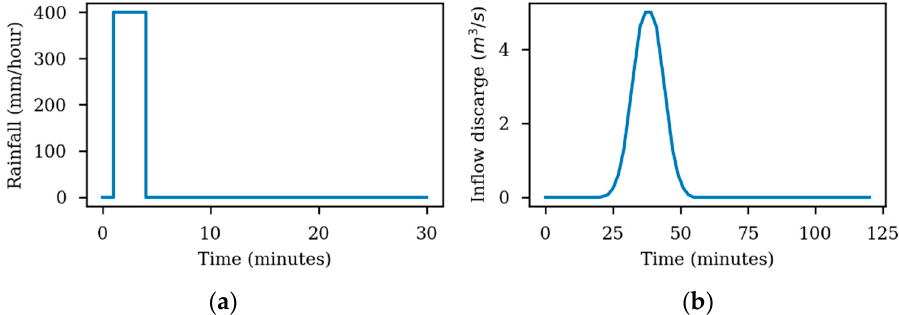
Figure 14. Water sources for Test 8A. ( a ) Hyetograph of the rain event in the simulation; ( b ) Hydrograph of the point inflow.